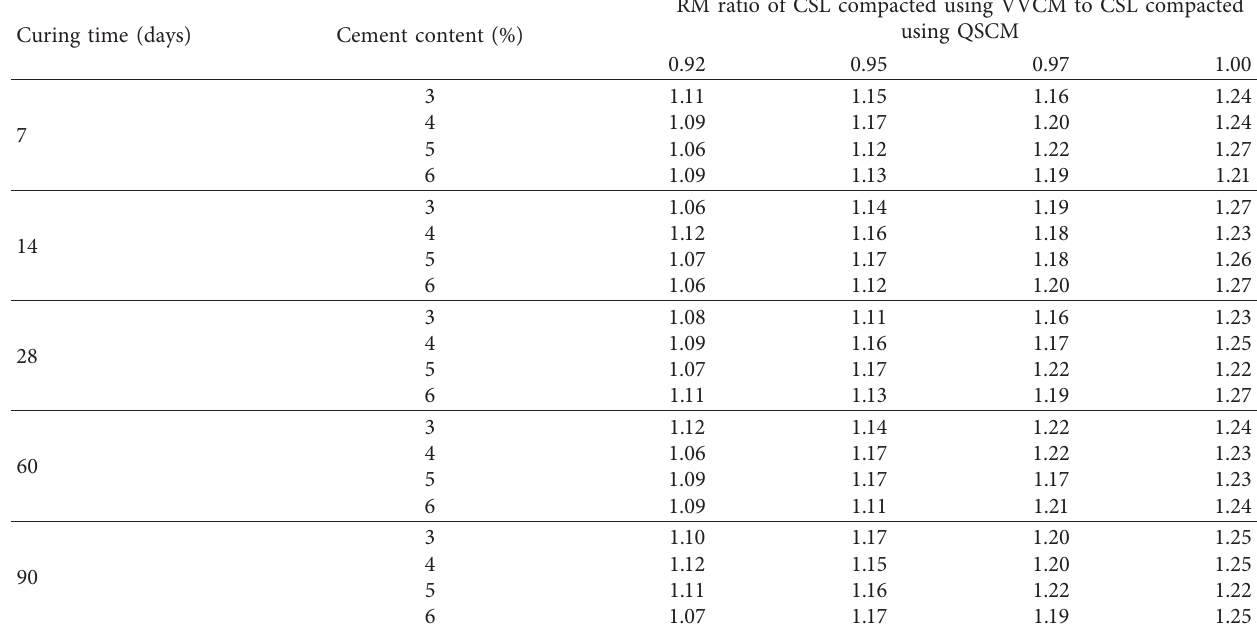
Table 11: RM ratio of CSL compacted using VVCM to CSL compacted using QSCM. Curing time